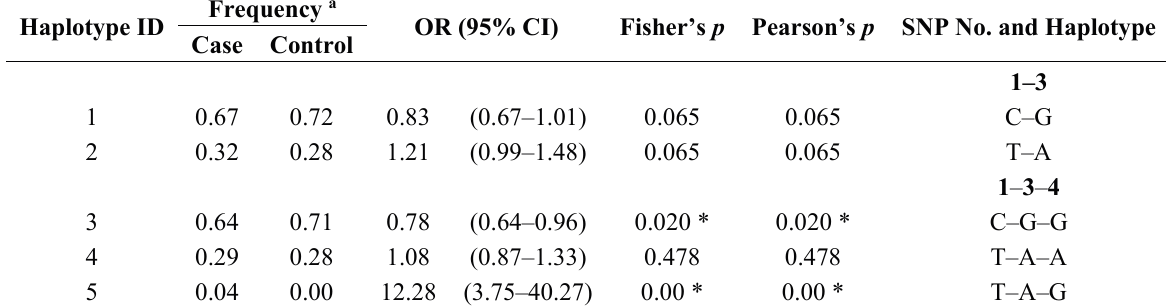
Table 4. Haplotype frequency of PSCA variation and the association with GAC